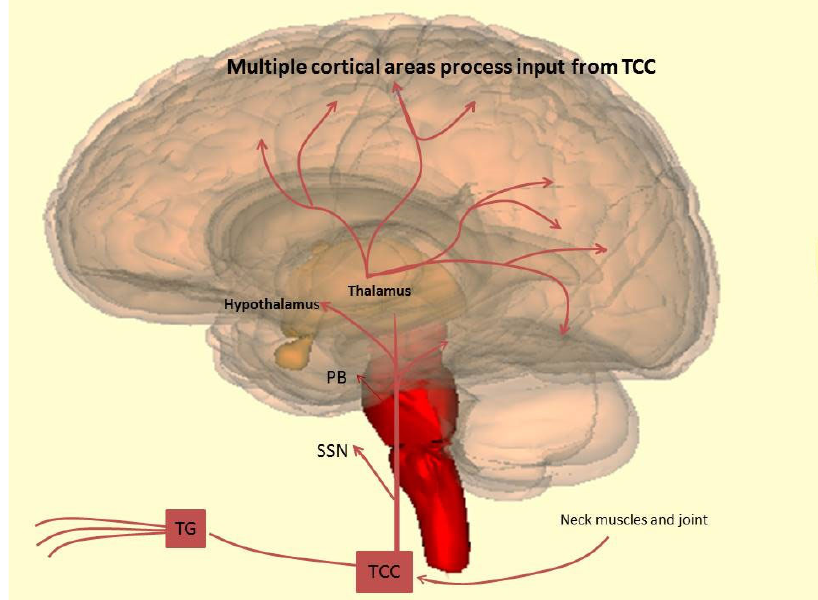
Figure 1. Multiple cortical areas process input from TCC.